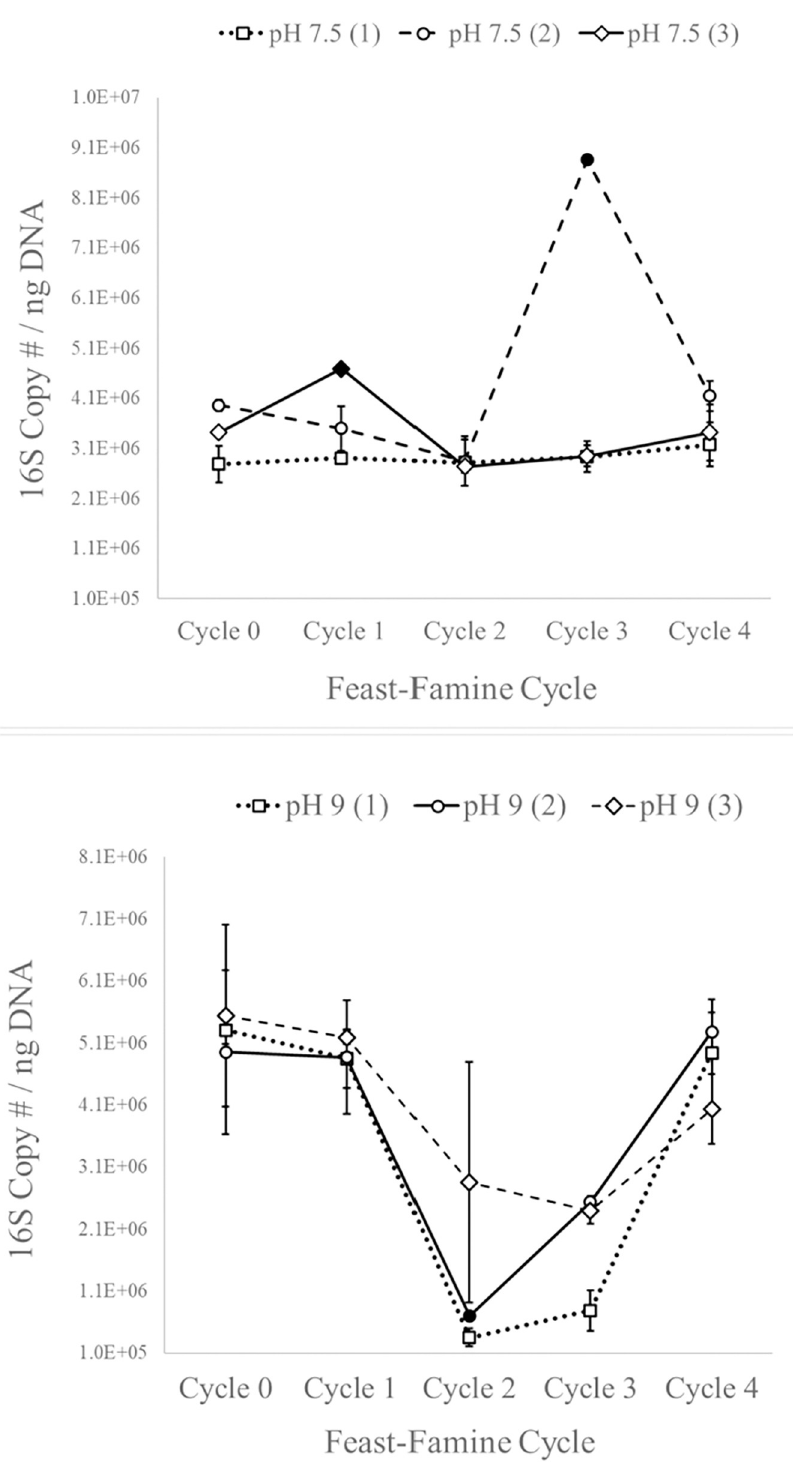
Fig 4. Total 16S rRNA gene copy number normalized to ng DNA. Indication of bacterial DNA to total DNA ratio for biological triplicate reactors at pH 9 and pH 7.5. Error bars represent range of duplicate readings (solid filled data point indicates a sample for which only one reading was